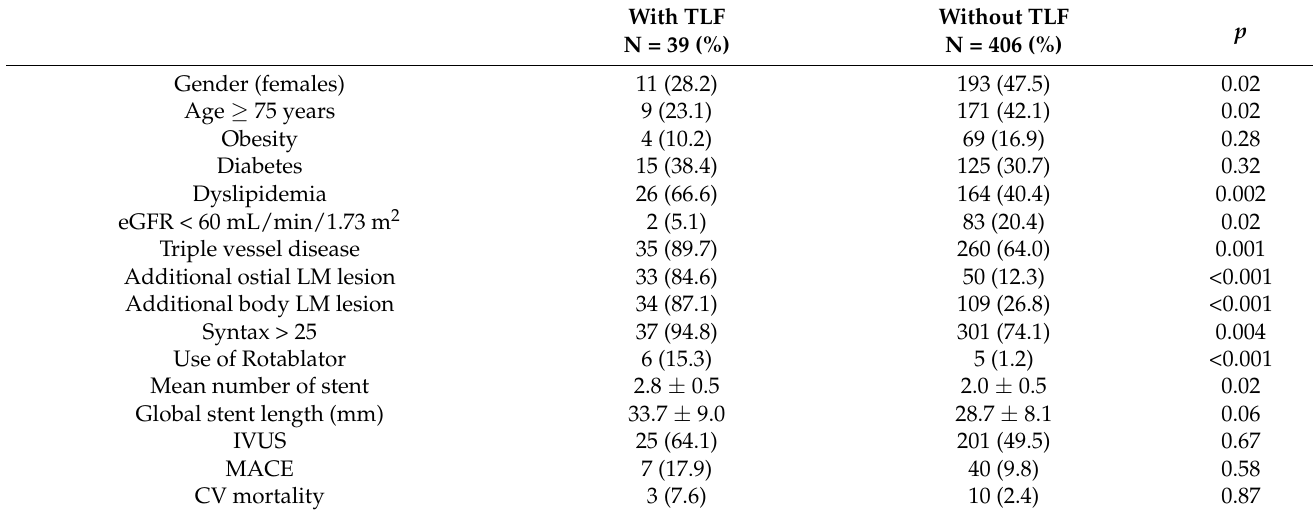
Table 5. Clinical, anatomical, and procedural parameters distribution among patients with and without TLF at 3 years of